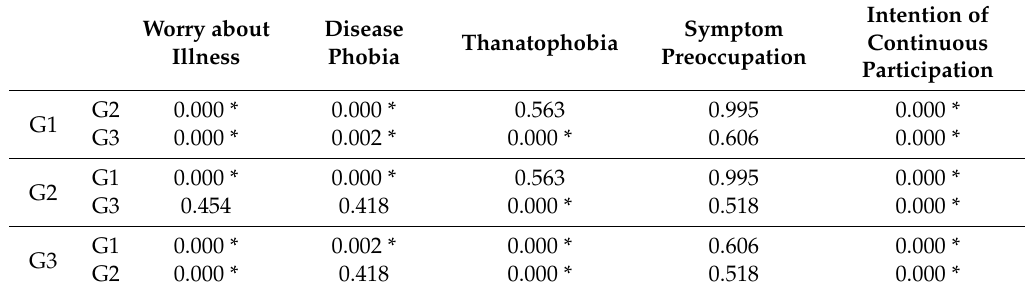
Table 4. Results of post hoc analyses: Di ff erences on dependent variables by age groups.